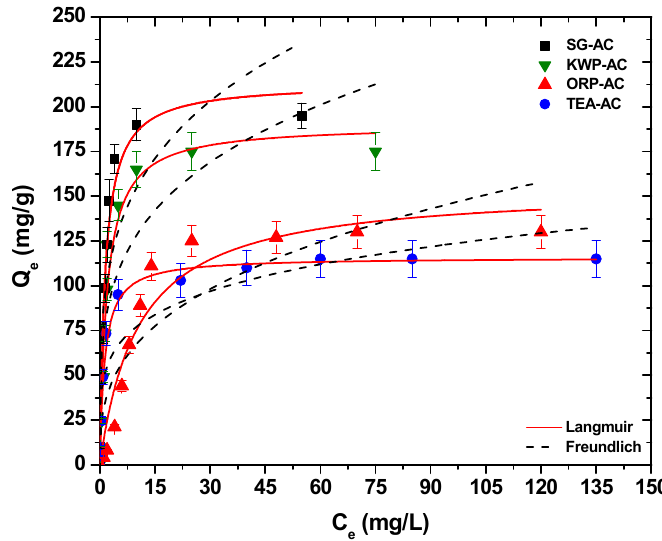
Table 3. Equilibrium parameters for the adsorption of PRM onto AC samples.